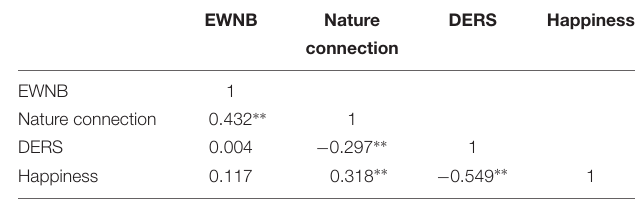
TABLE 6 | Predictors of improvement in happiness.